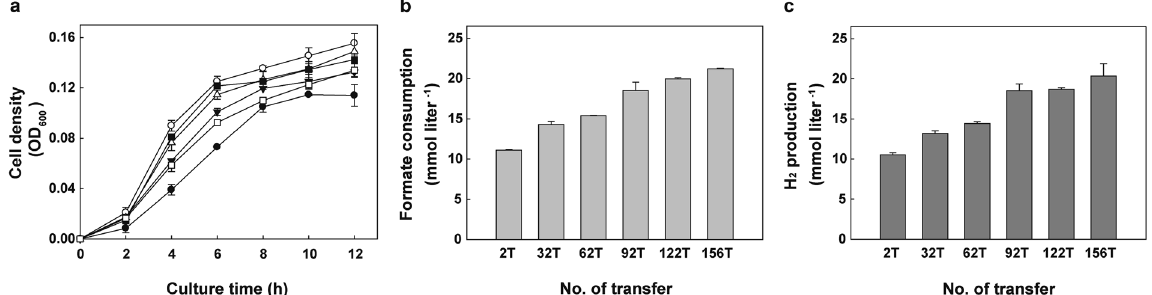
Figure 1. Physiological changes of T. onnurineus NA1 through serial transfers into fresh MM1 medium containing 147 mM sodium formate. After 2 (closed circle), 32 (open square), 62 (closed inverted triangle), 92 (open triangle), 122 (closed square) and 156 (open circle) transfers, the cell density (expressed as optical density at 600 nm) ( a ) was determined at the indicated time points. Formate consumption rates ( b ) and H 2 production rates ( c ) were determined during the exponential phase. All experiments were conducted independently in